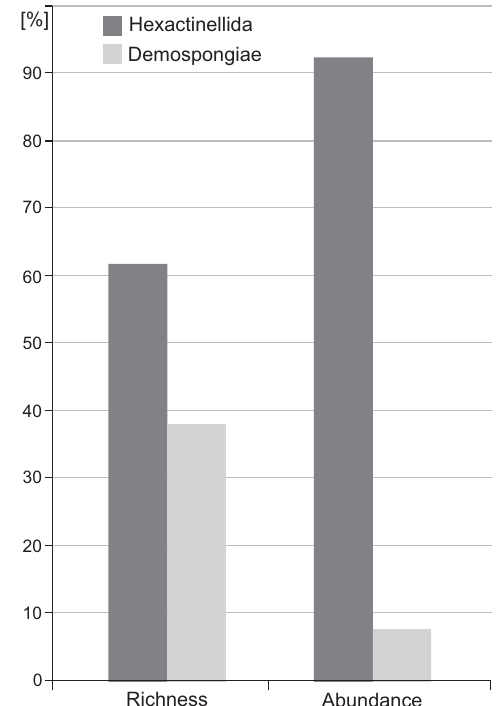
Fig. 5. Distribution of species richness (number of taxa) and species abun- dance (number of individuals per taxon) among classes.